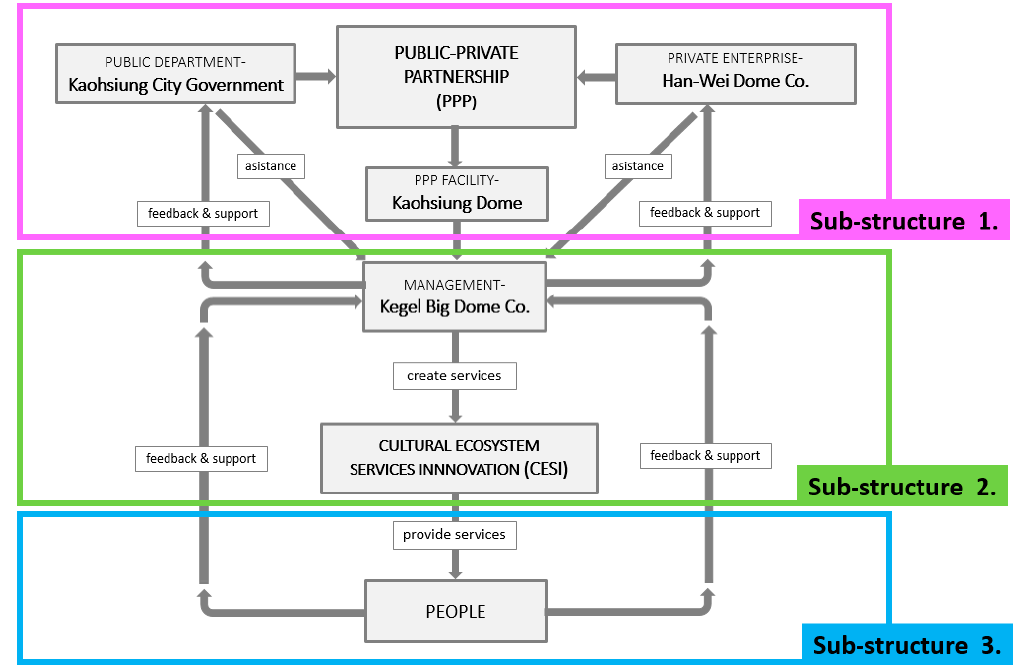
Figure 7. Kaohsiung Dome PPP-CESI Research Structure.